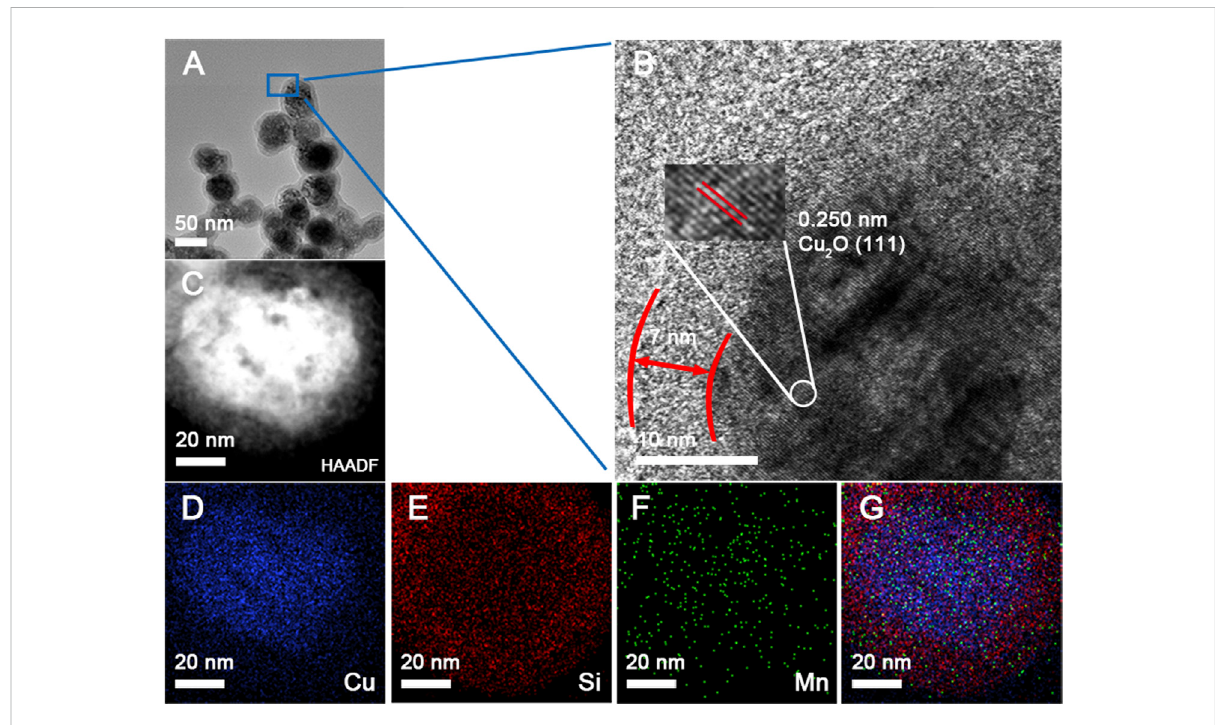
FIGURE 2 (A,B) TEMandHRTEMimagesofCu 2 O@SiO 2 /MnO 2 − PEG. (C − G) HAADF − STEMimageandelementmappingofCu,Si,andMn,aswellasoverall maps for the Cu 2 O@SiO 2 /MnO 2 − PEG composite.